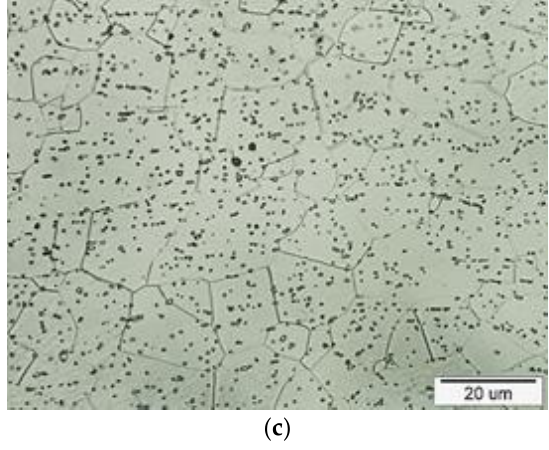
Figure 11. ( a ) Overall image of the AISI 430 laser-welded joint microstructure; ( b ) detail of microstructure of AISI 430 welded joint; ( c ) AISI 430 base material microstructure. The comparison of the dependence of the true stress on the true strain shown in Figure 12 makes it clear that at the same strain (e.g., a strain of 0.05) the laser welded AISI 304 LW samples required only about a 2 MPa greater actual stress than the samples of the AISI 304 BM base material.